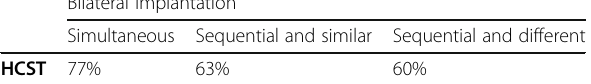
Table 5 HCST average scores with bilateral implants 1 year after the second implant showed the best score in the simultaneously implanted group followed by sequentially and similar implanted group with least score in sequential and different one Bilateral implantation Simultaneous Sequential and similar Sequential and